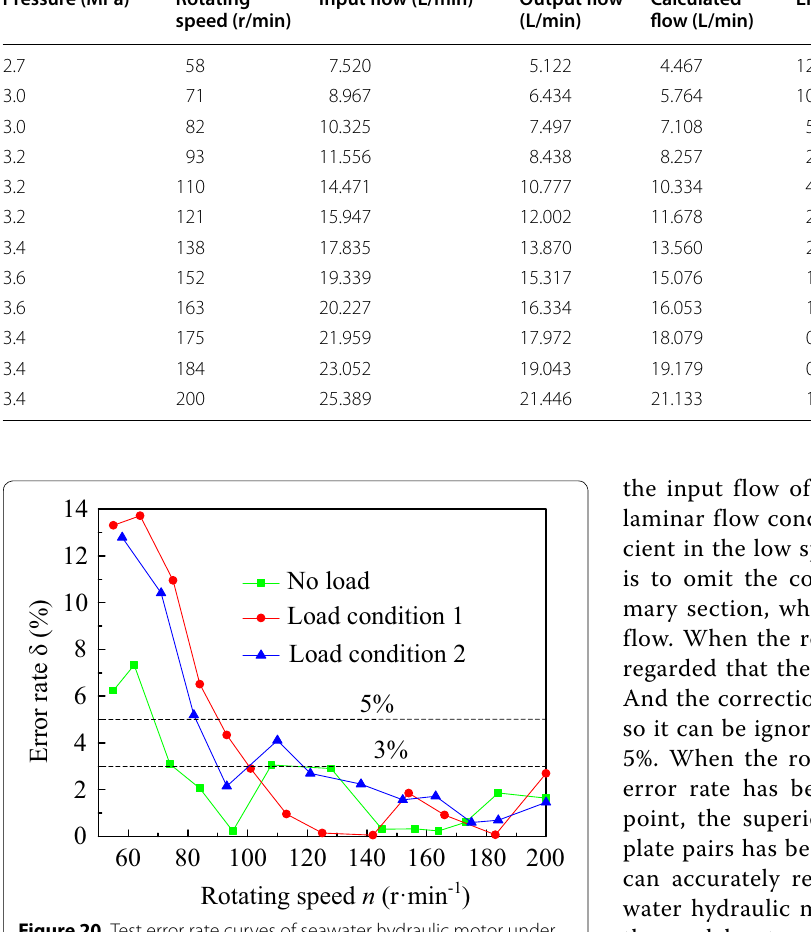
Table 6 Flow rate results of seawater hydraulic motor under load condition 2 Pressure (MPa) Rotating speed (r/min)